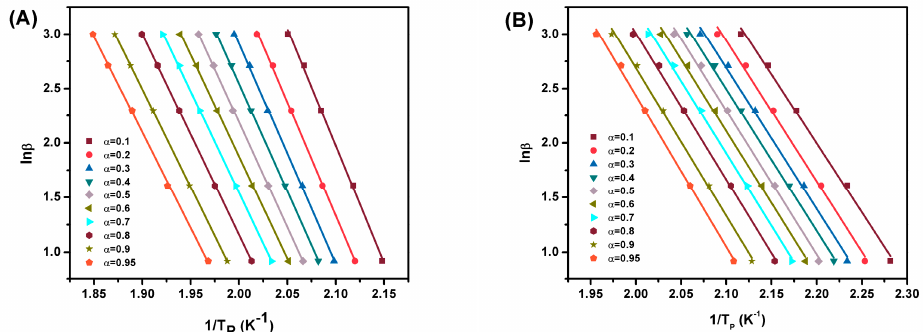
Polymers 2019 , 11 , x FOR PEER REVIEW Figure 4. ln β versus 1/T p plots for reaction 1 ( A ) and reaction 2 ( B ). Figure 4. ln β versus 1 / T p plots for reaction 1 ( A ) and reaction 2 ( B ).